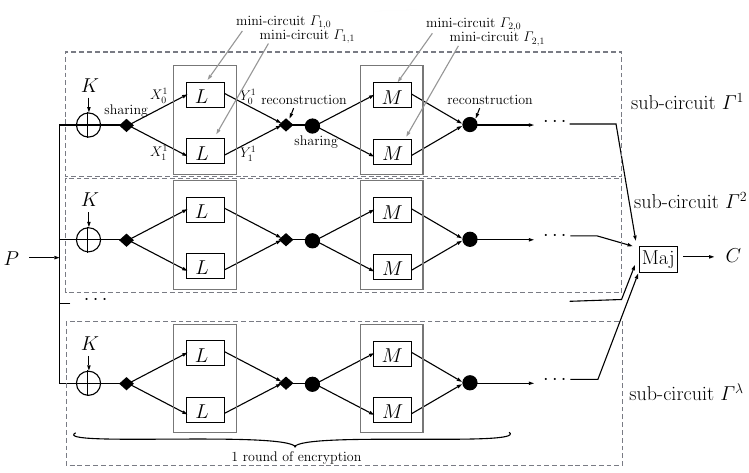
Figure 1: High-level view of the Trojan-resilient specification of our block cipher. The devices L and M are produced by the untrusted manufacturer and are assembled together by a trusted master that takes care of the required sharings and reconstructions. The ciphertext is obtained by computing the majority over the output of the λ sub-circuits. MOE consists of λ sub-circuits, where each sub-circuit Γ j has exactly the same structure (hence we will sometimes abuse notation and omit the parameter j ). Each sub-circuit Γ consists of 2 κ mini-circuits ((Γ Γ ) , . . . , (Γ Γ )), where each pair of 1 , 0 , 1 , 1 κ, 0 , κ, 1